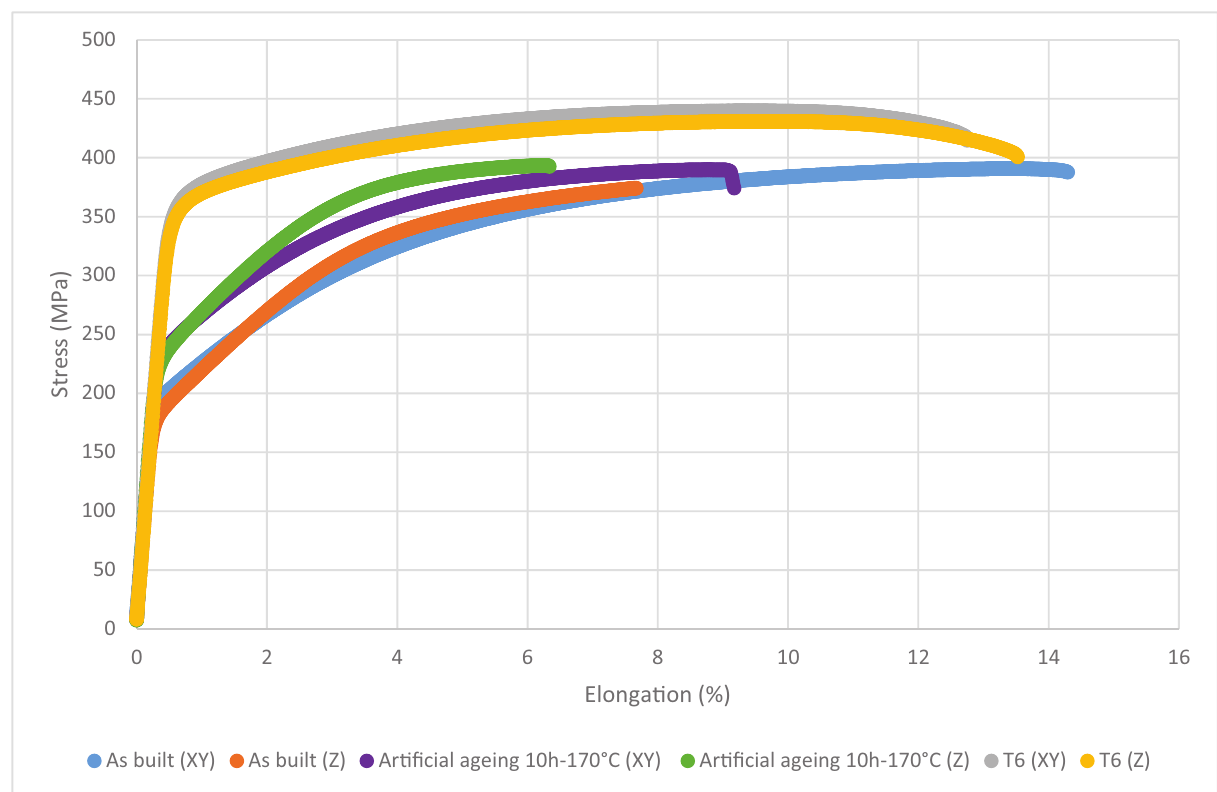
Fig. 12. Engineering stress-strain curves (cid:1) AlSi5Cu3Mg